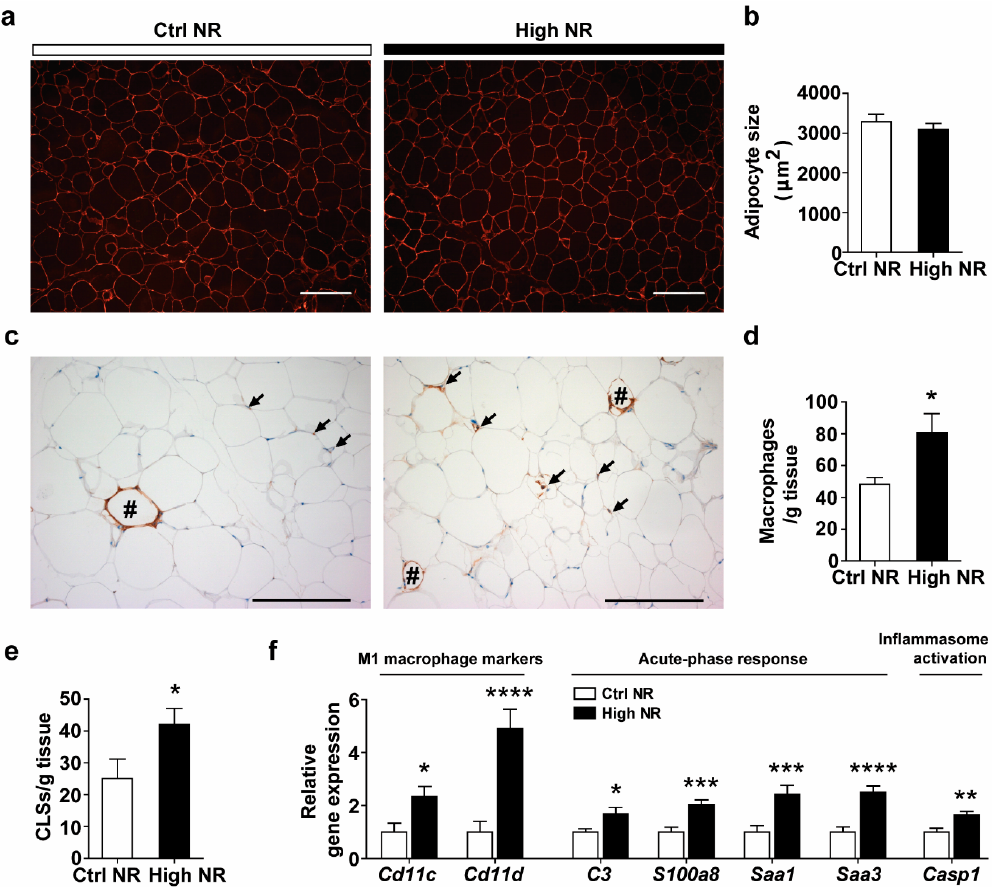
Figure 5. High NR impairs visceral WAT function, characterized as more severe inflammation. Representative images of cell size ( a ) and mean adipocyte size ( b ). Representative images of crown like structures (CLSs) (indicated by hashes) as well as single macrophages (indicated by arrows). Scale bar represents 200 µm. Single macrophages and CLSs were counted ( n = 8 animals per treatment) and expressed as macrophages or CLSs per gram eWAT weight ( d and e ). Relative gene expression (normalized to the reference genes) of pro-inflammatory genes ( f ). Control NR: white bar; high NR: black bar ( n = 11–12 per treatment). Data are analyzed using Student’s t -test and presented as mean ± SEM. * p < 0.05, ** p < 0.01, *** p < 0.005, **** p < 0.001.